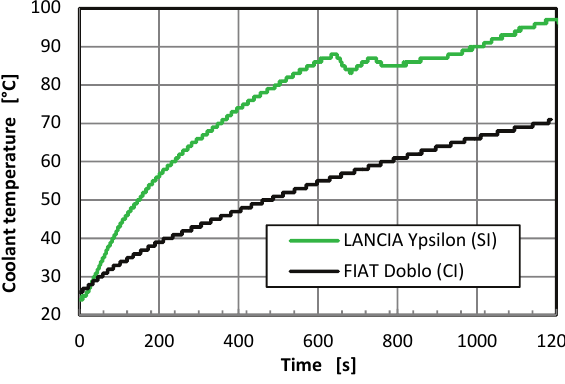
Fig. 11. The coolant temperature at the ambient temperature